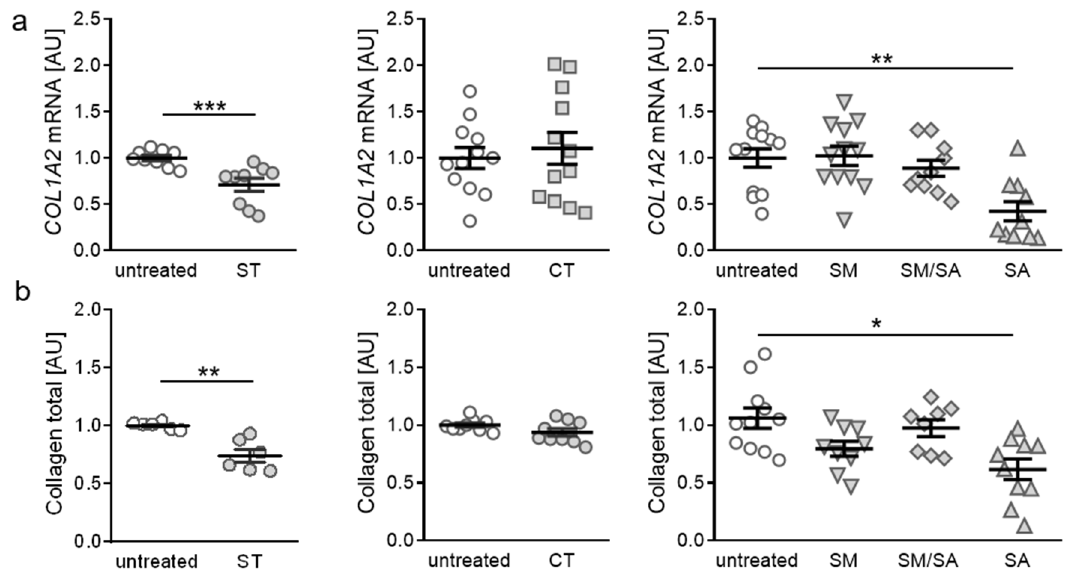
Figure 4. Expression of COL1A2 ( a ) and total collagen content in cell culture supernatant ( b ) after application of different tensile strain protocols (explanation see manuscript text). AU: arbitrary units, error bars represent standard error of the mean. n > 6; Statistics: ST/CT: Mann-Whitney-U tests; SM, SM/SA, SA: Welch-corrected ANOVA with Games-Howell posthoc tests; * p < 0.05, ** p < 0.01, *** p < 0.001.